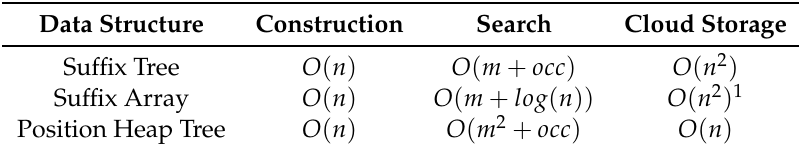
Table 1. Comparison of plaintext substring search data structures. n is the length of the text t , m is the length of the substring χ , occ is the number of occurrences of χ in t